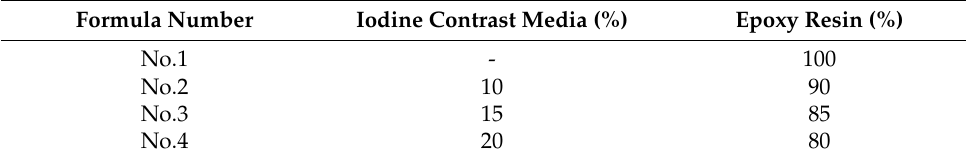
Table 1. Epoxy resin with iodine contrast media in different proportions ( v / v